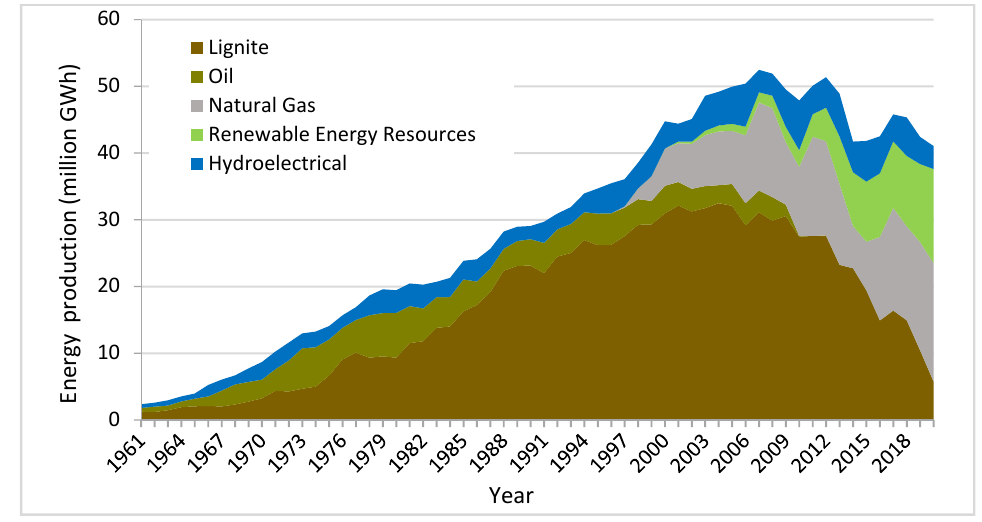
Figure 2. Electricity generation by source (GWh) in the interconnected system of Greece (1961– 2020).